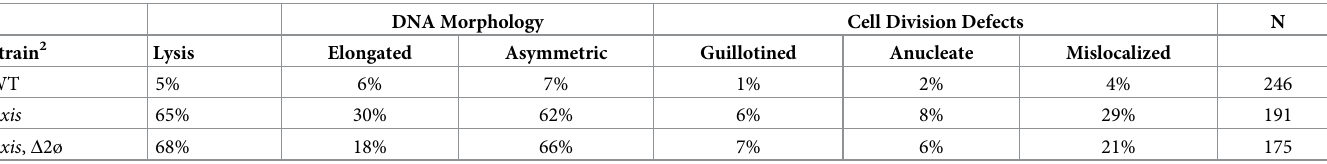
Table 2. DNA morphology and cell division defects following expression of ICE Bs1 1